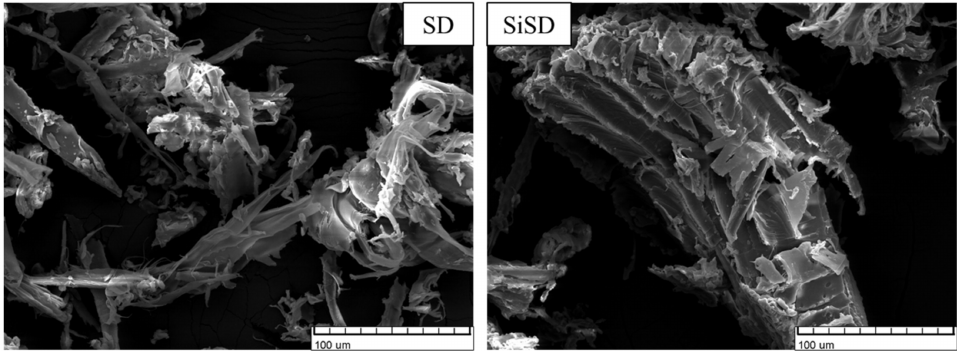
Figure 5. SEM images of sawdust (SD) and silanized sawdust (SiSD).